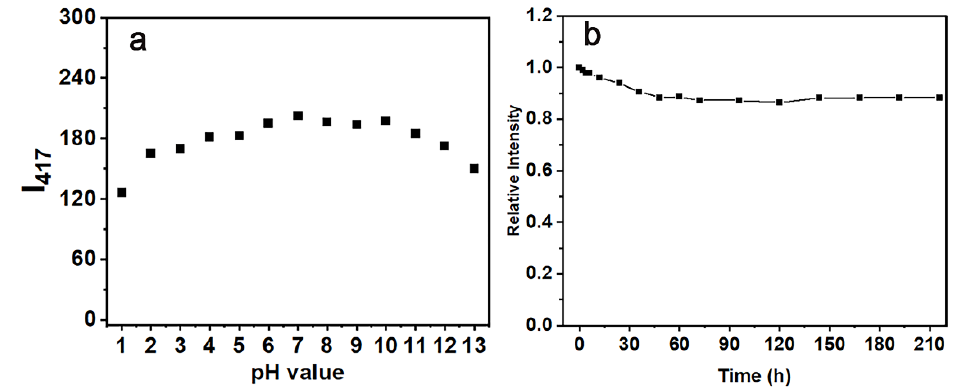
Figure 7. ( a ) Fluorescence intensities at 417 nm of the N-CQD-13 solutions under different pH values